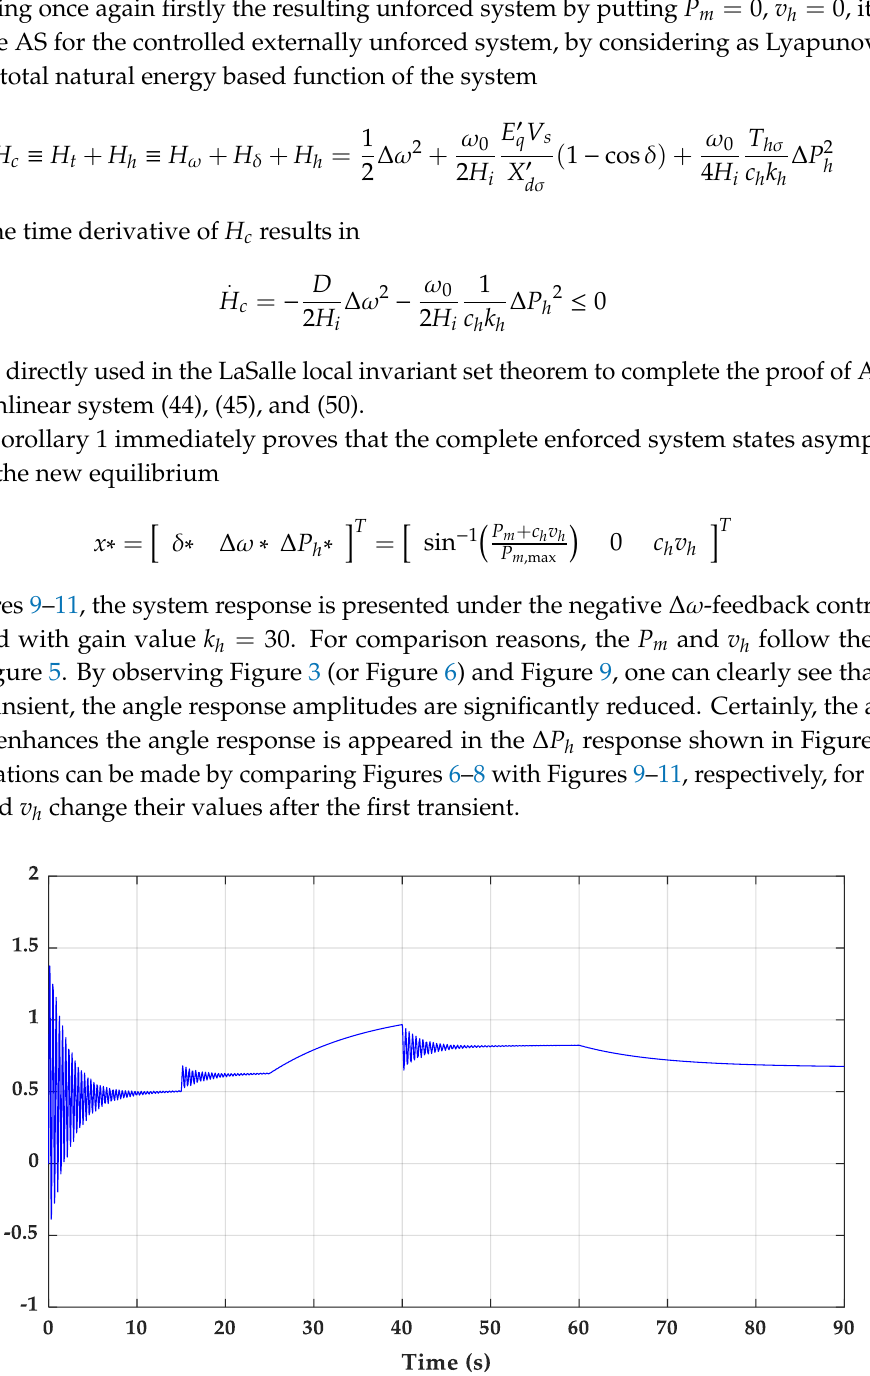
Figure 10. Response of the angular speed of the SGIB with feedback.